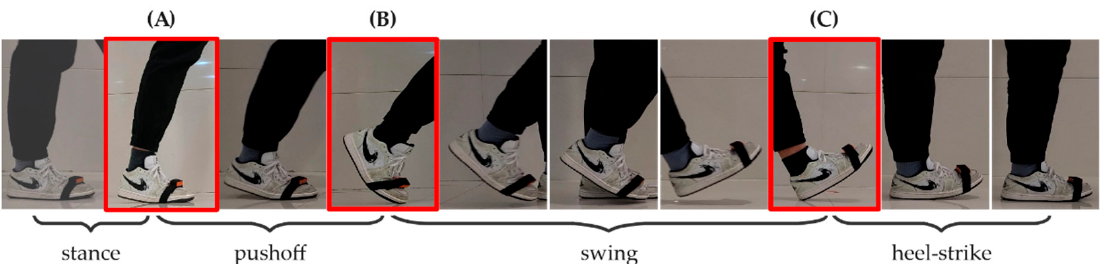
Figure 3. The movement of a whole stride can be divided into four gait phases. ( A ) displays that the heel just leaves the ground at the end of stance phase; ( B ) displays that the toe is going to leave the ground at the end of pushoff phase; ( C ) displays that the heel touches the ground at the end of swing